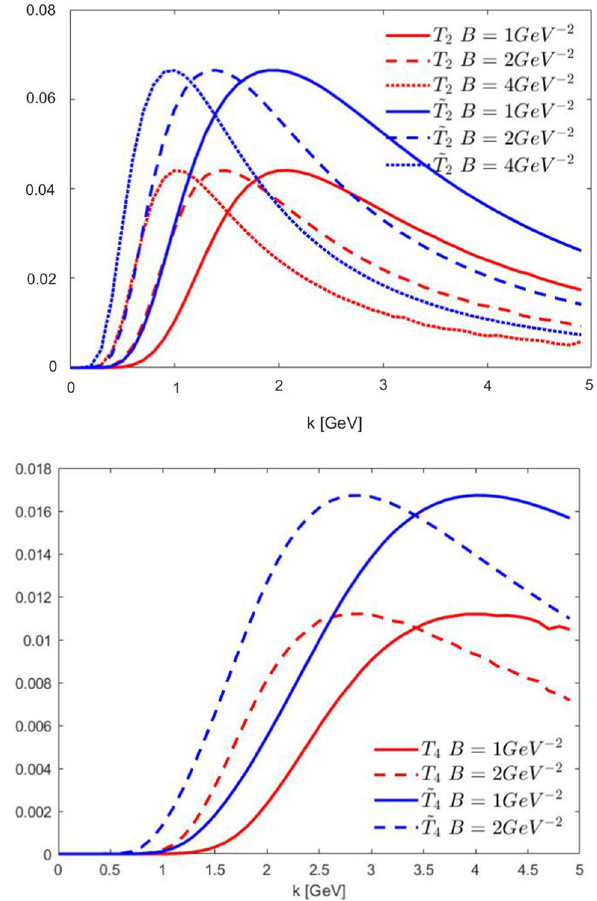
Fig. 3 Above: The integrals T 2 and ˜ T 2 when all momenta are equal, k 1 = k 2 = k 3 = k for different values of the parameter B = 1 ( 2 , 4 ) GeV − 2 in full (dashed,dotted) line. Below: The integrals T 4 and ˜ T 4 when all momenta are equal, k 1 = k 2 = k 3 = k for different values of the parameter B = 1 ( 2 ) GeV − 2 in full (dashed)